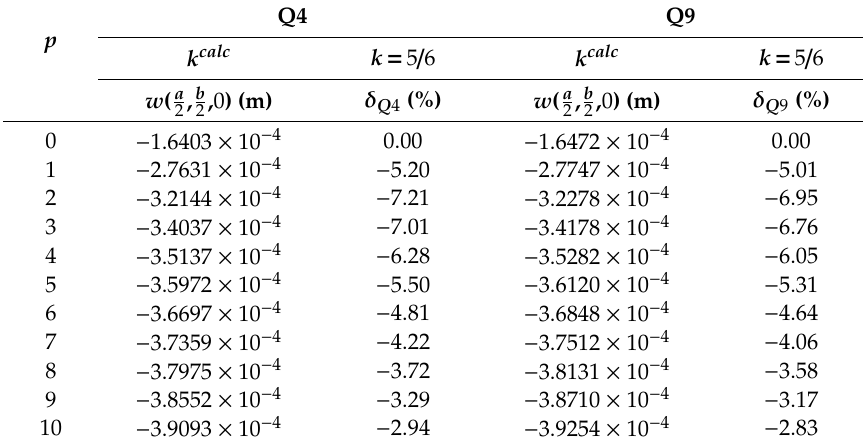
Table 8. Porosity distribution model M2: plate’s center transverse displacement for di ff erent finite elements and shear correction factor approaches.